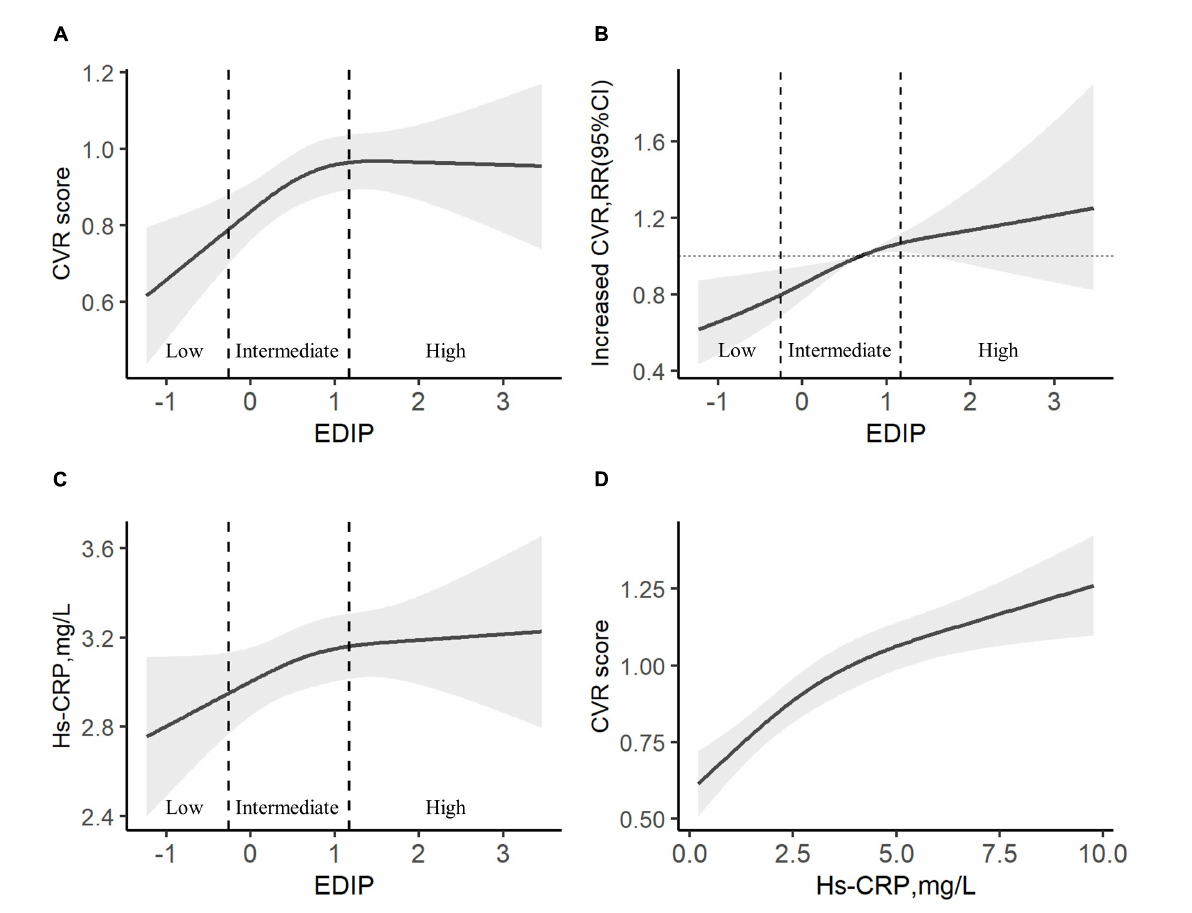
FIGURE1 The association among EDIP scores, CVH, and hs-CRP. (A) A cubic curve-fitting model of the curvilinear association between EDIP and CVR score. (B) A restricted cubic spline hazard of the curvilinear association between EDIP and Increased CVR. (C) A cubic curve-fitting model of the curvilinear association between EDIP and hs-CRP. (D) A cubic curve-fitting model of the curvilinear association between hs-CRP and CVR score. All models were adjusted for age, residence, education, income, pre-pregnancy BMI, parity, gestational weight gain, family history of diabetes and hypertension, physical activity, outdoor time, sedentary time, and vitamin D supplementation frequency. Increased CVR, CVR score > 0 points. CVR, cardiovascular risk, EDIP, Empirical dietary inflammation